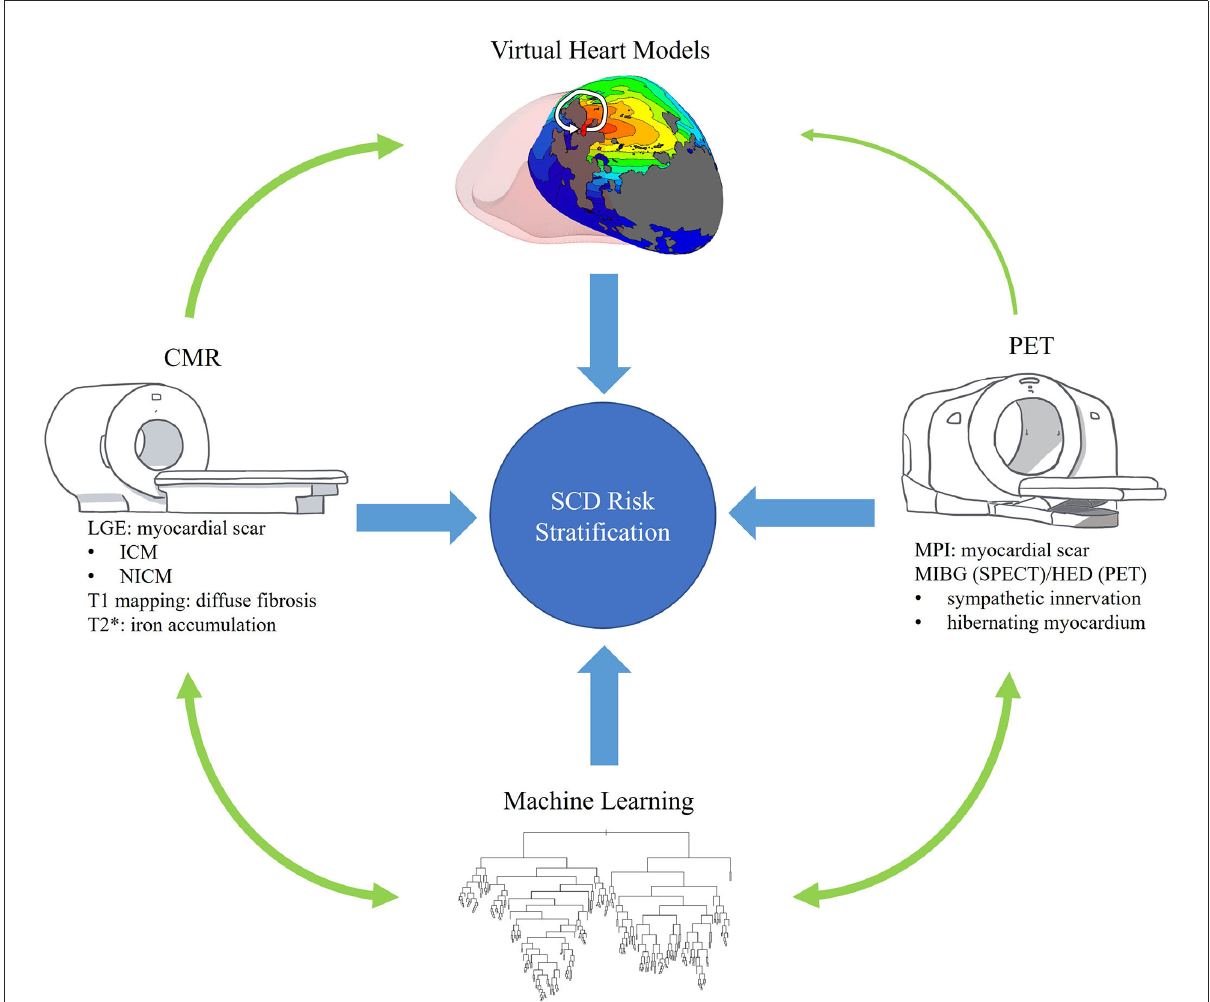
FIGURE1 Overview. This review seeks to describe the role of advanced imaging in the risk stratification of SCD and its interplay with promising technologies such as machine learning and personalized virtual heart models. This figure visually summarizes these goals and highlights some of the content to be